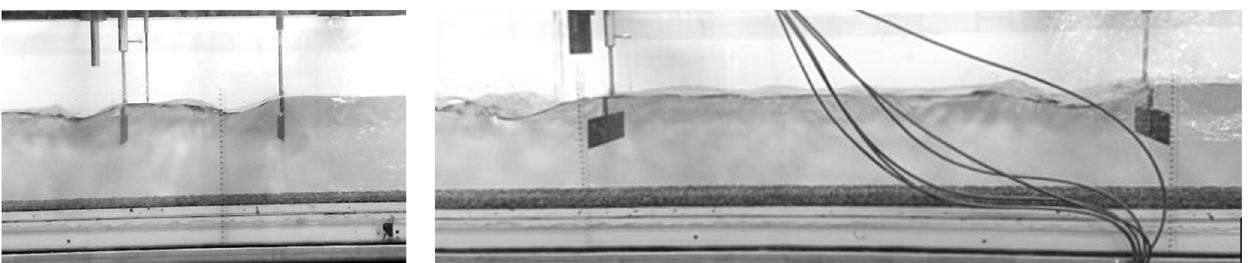
Figure 14. ( Left ) Discharge Q c = 32.3 l/s, spacing between the plates d = 0.316 m, height from the bottom y z = 0.115 m, upstream depth h 0 = 0.20 m, upstream flow speed U 0 = 0.530 m/s, and measured thrust force over the first plate = 7.51 N. ( Right ) Discharge Q c = 35.7 l/s, spacing between the plates d = 1.0 m, height from the bottom y z = 0.101 m, upstream depth h 0 = 0.201 m, upstream flow speed U 0 = 0.583 m/s, and measured thrust force over the first plate = 5.54 N.